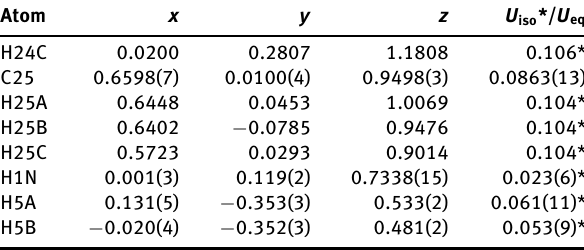
Table 2: Fractional atomic coordinates and isotropic or equivalent isotropic displacement parameters (Å 2